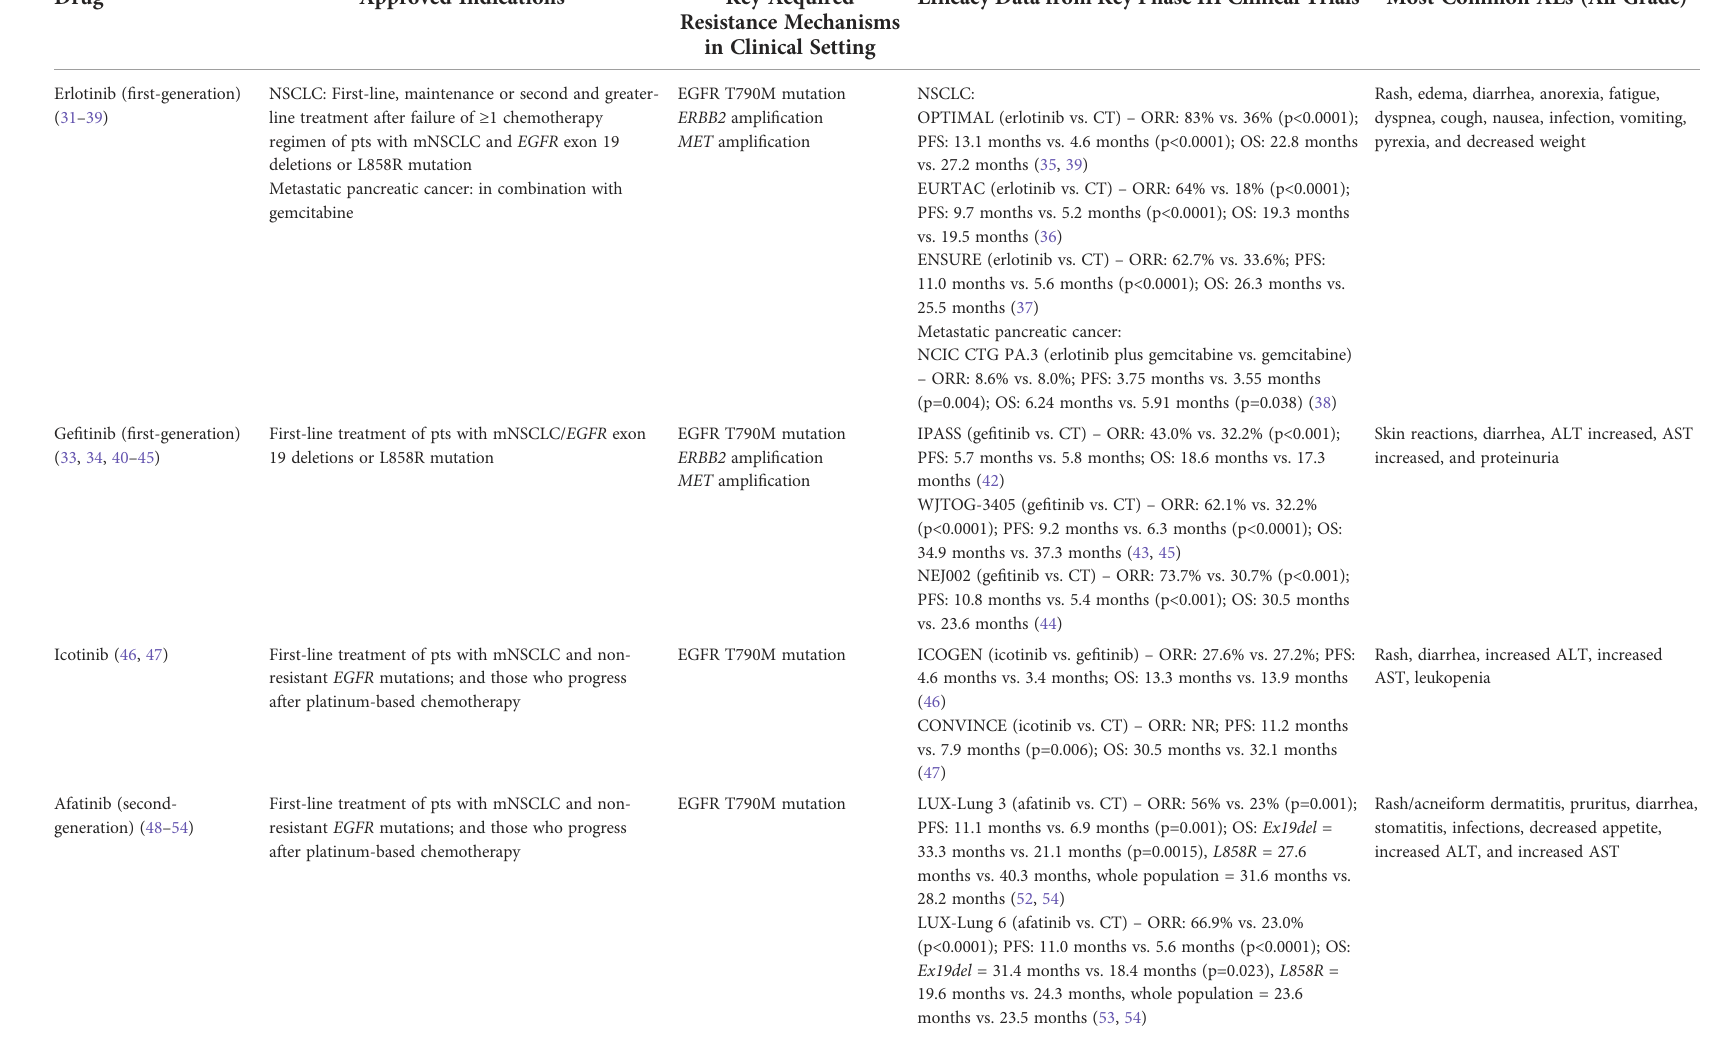
TABLE 1 Clinically approved inhibitors of EGFR signaling, acquired resistance mechanisms, clinical ef fi cacy, and safety pro fi le identi fi ed in patients with